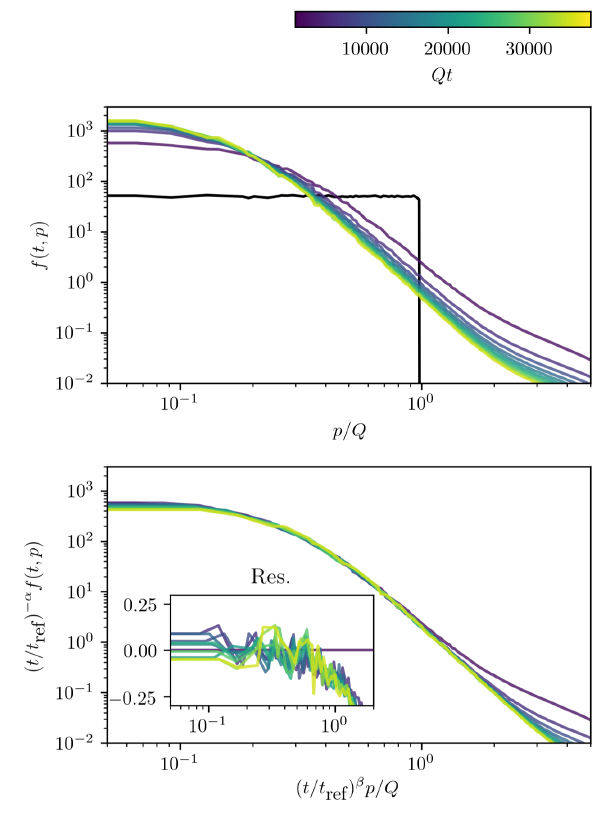
Figure 1: Occupation number distributions in the infrared. In black: The initial unrescaled occupation number distribution.